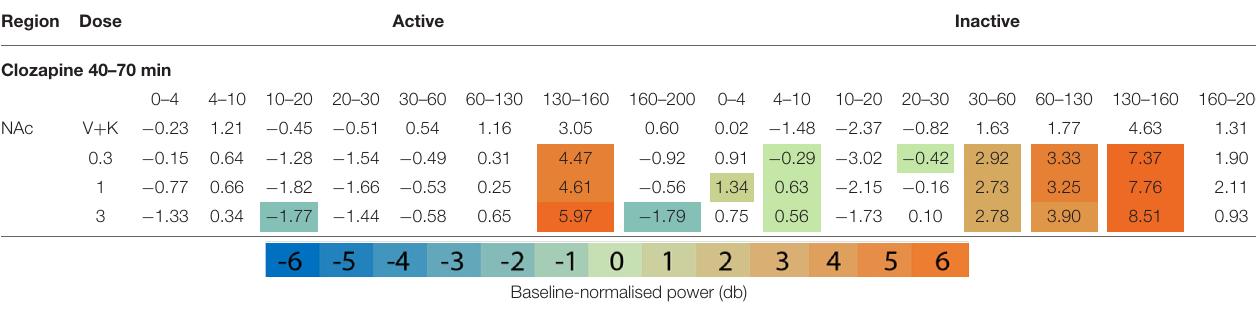
TABLE 3 | Table of averaged power spectra at 40–70min. Region Dose Active Inactive Clozapine 40–70